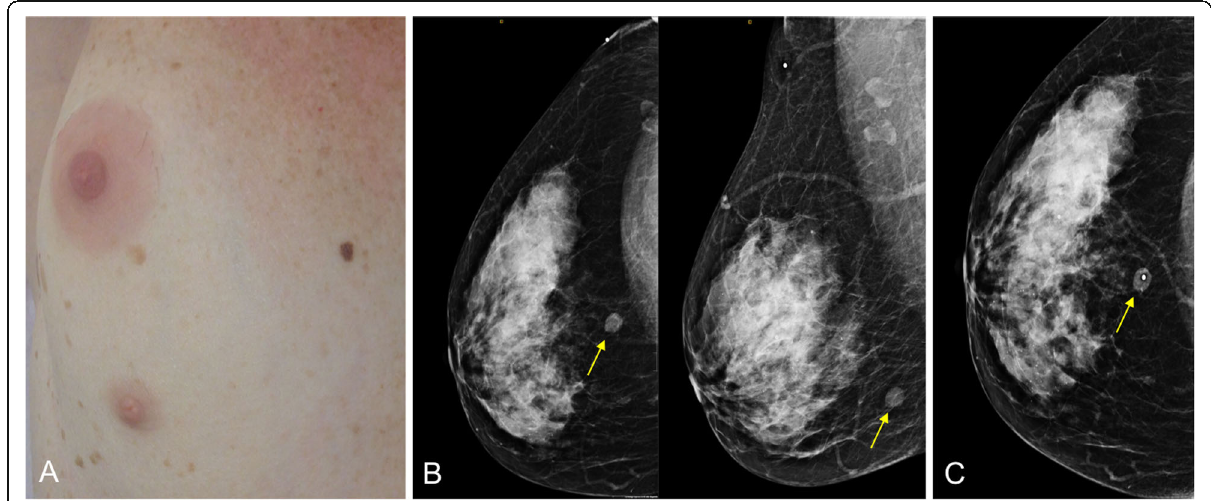
Fig. 4 Developmental abnormalities. a Photograph of polythelia in the right breast of a 45-year-old woman. b Craniocaudal and mediolateral oblique 2D mammograms show a nodule with well-defined margins in the posterior region of the junction between the lower quadrants. c Repeat craniocaudal mammogram with a cutaneous marker confirms that the nodule corresponds to the accessory